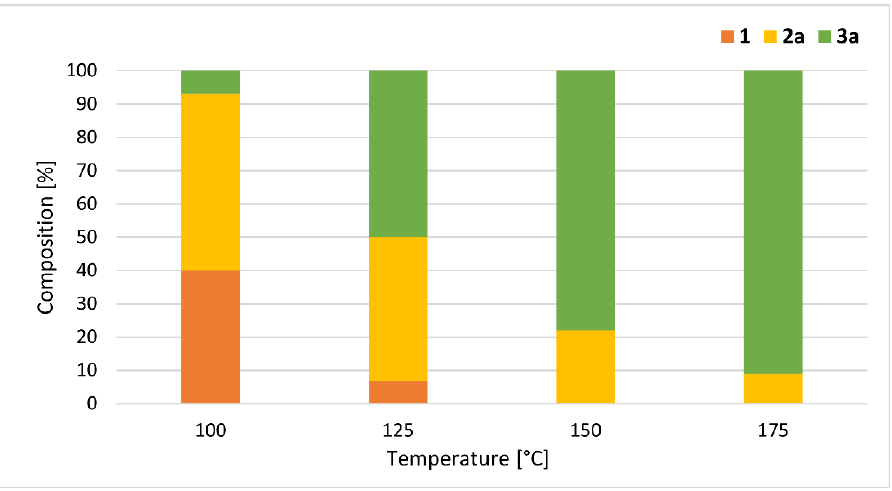
Figure 3. Composition of the reaction mixtures of the MW-assisted alcoholysis of DMP with n BuOH at different temperatures at a residence time of 30 min (Table 3 entries 3 and 7 – 9).